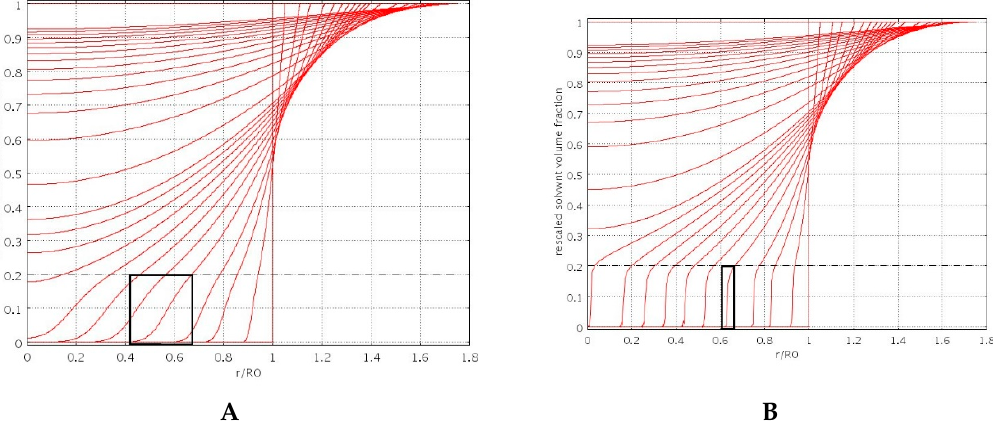
Figure 2. Rescaled solvent volume fraction φ (r,t)/ φ eq , vs. dimensionless radius r/R 0 for increasing times during the swelling process. Dashed line indicates the value of φ G / φ eq , Black boxes highlight the thickness of the diffuse glassy-rubbery interface. ( A ) β = 2, porous particle; ( B ) β = 8, non-porous particle.